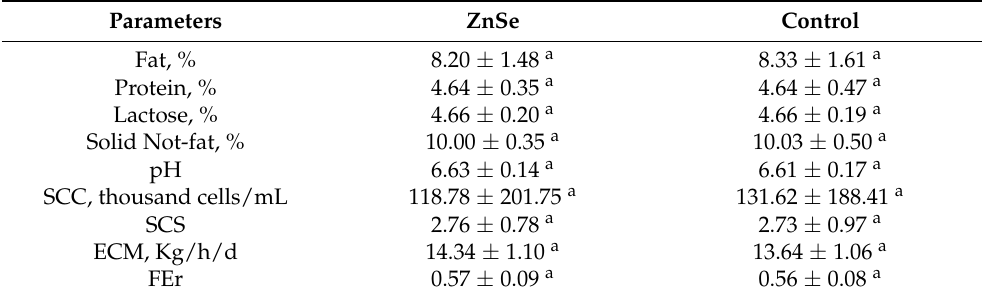
Table 5. Results of milk quality traits, energy-corrected milk (ECM), and feed efficiency ratio (FEr) between the two groups under examination. Data are expressed as Lsmeans ± SE. a Same letters indicate no significant differences